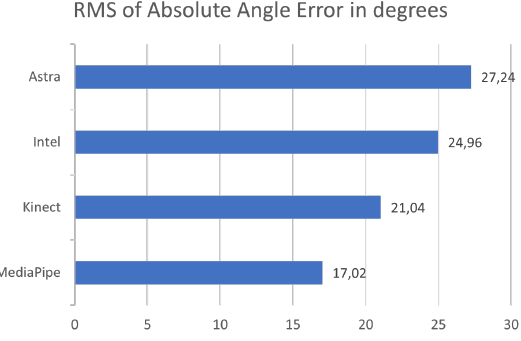
Figure 9. Absolute error RMS plot comparing all sensors for error dispersion.